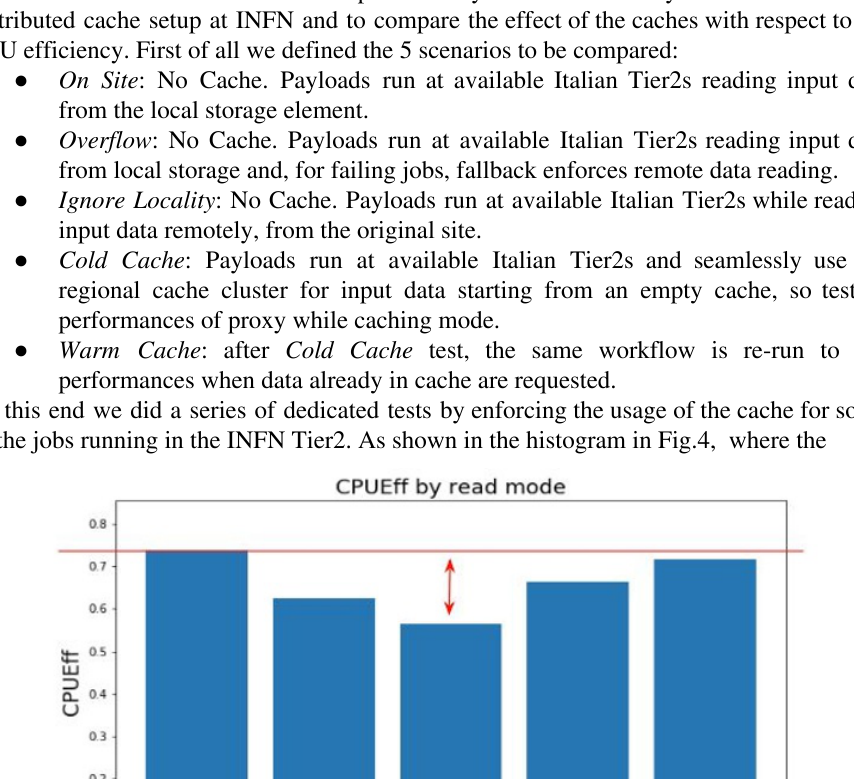
Fig. 3. Mean value of CPU eff. by identified scenarios. Red line shows how the us to reach almost the same value of the CPU eff. obtained running jobs that read from local storage. The arrow highlights the loss of CPU